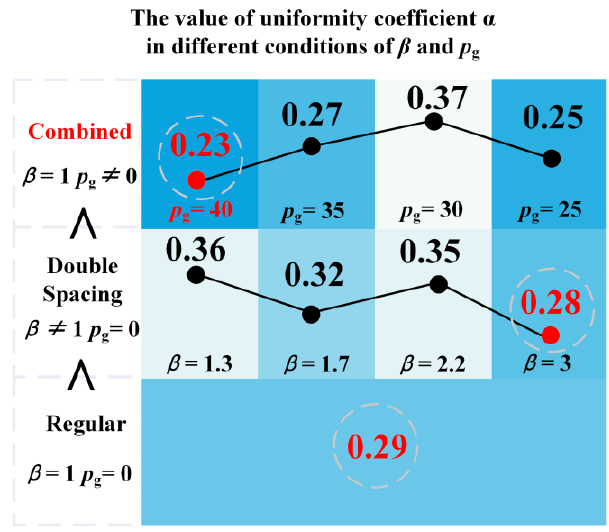
Figure 11. Magnetic distributions of the improved coils: ( a ) double-spacing DD coil; ( b ) combined DD coil.